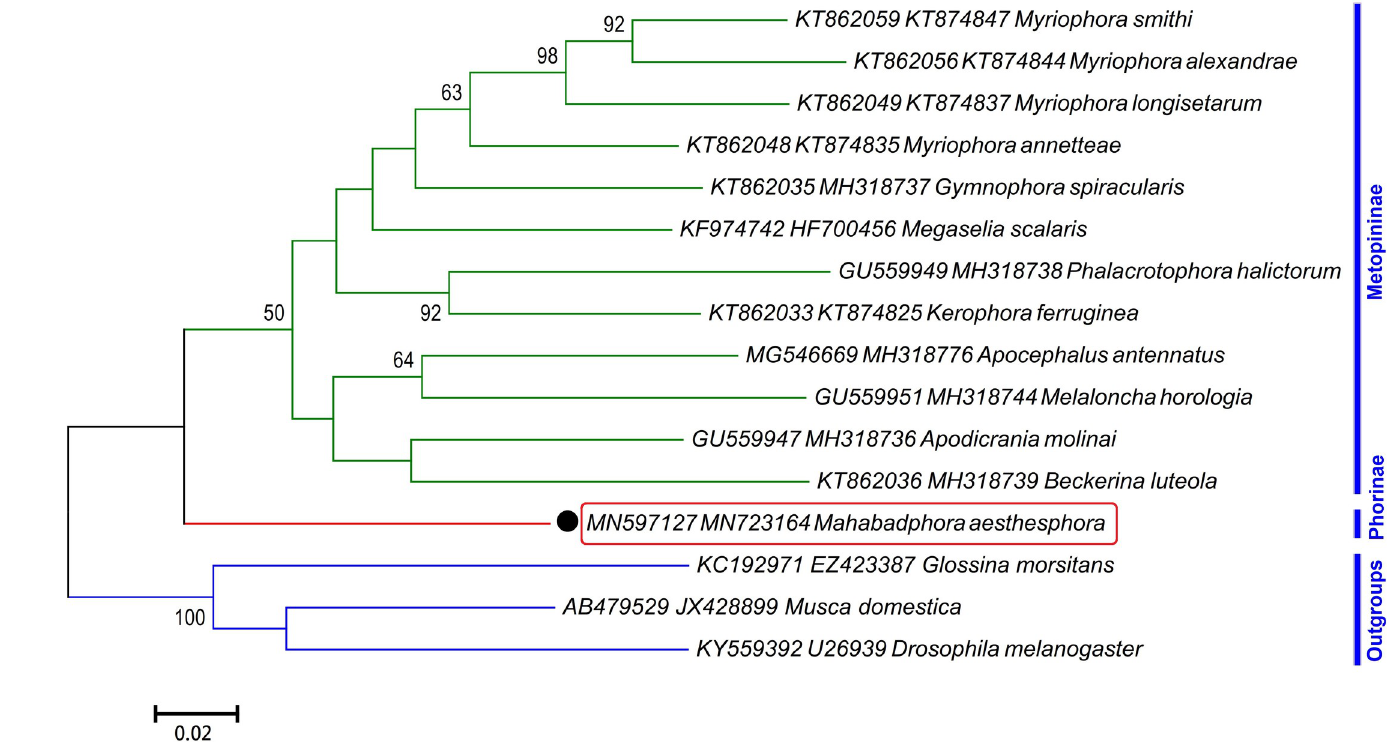
Fig 6. Maximum likelihood tree inferred from 1263 bp of the COI - AK gene sequences of the new genus described in this study. Only bootstrap values higher than 50% are shown on the branches. The bar indicates substitutions per site. The Drosophila melanogaster (Meigen, 1830) (KY559392 and U26939), Glossina morsitans Westwood, 1851 (KC192971 - EZ423387) and Musca domestica Linnaeus, 1758 (AB479529 - JX428899) were set as